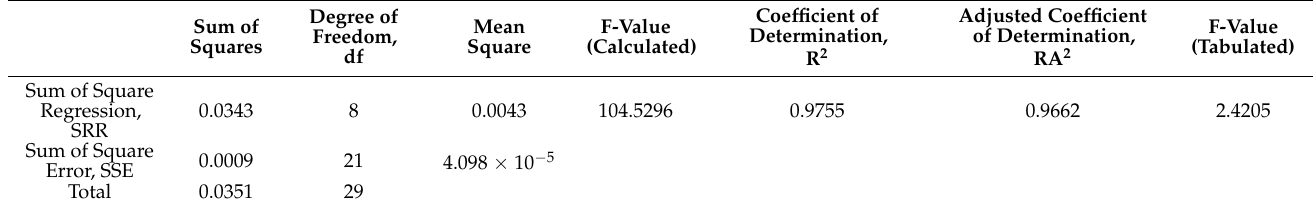
Table 4. ANOVA of response surface model for straight drilled cooling channels.